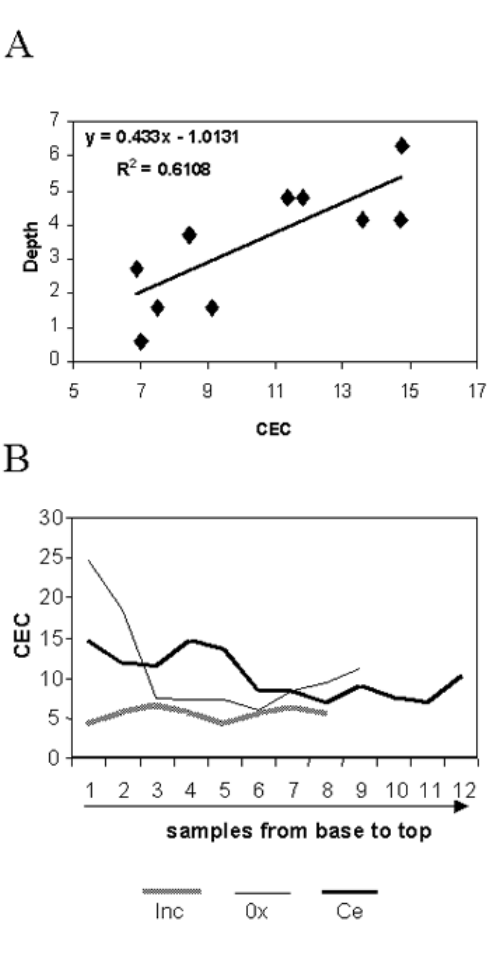
Fig. 5 – (A) correlation between CEC of the clays and depth in Ce- ramarte Mine and (B) the variation of CEC with depth in the three Mines.